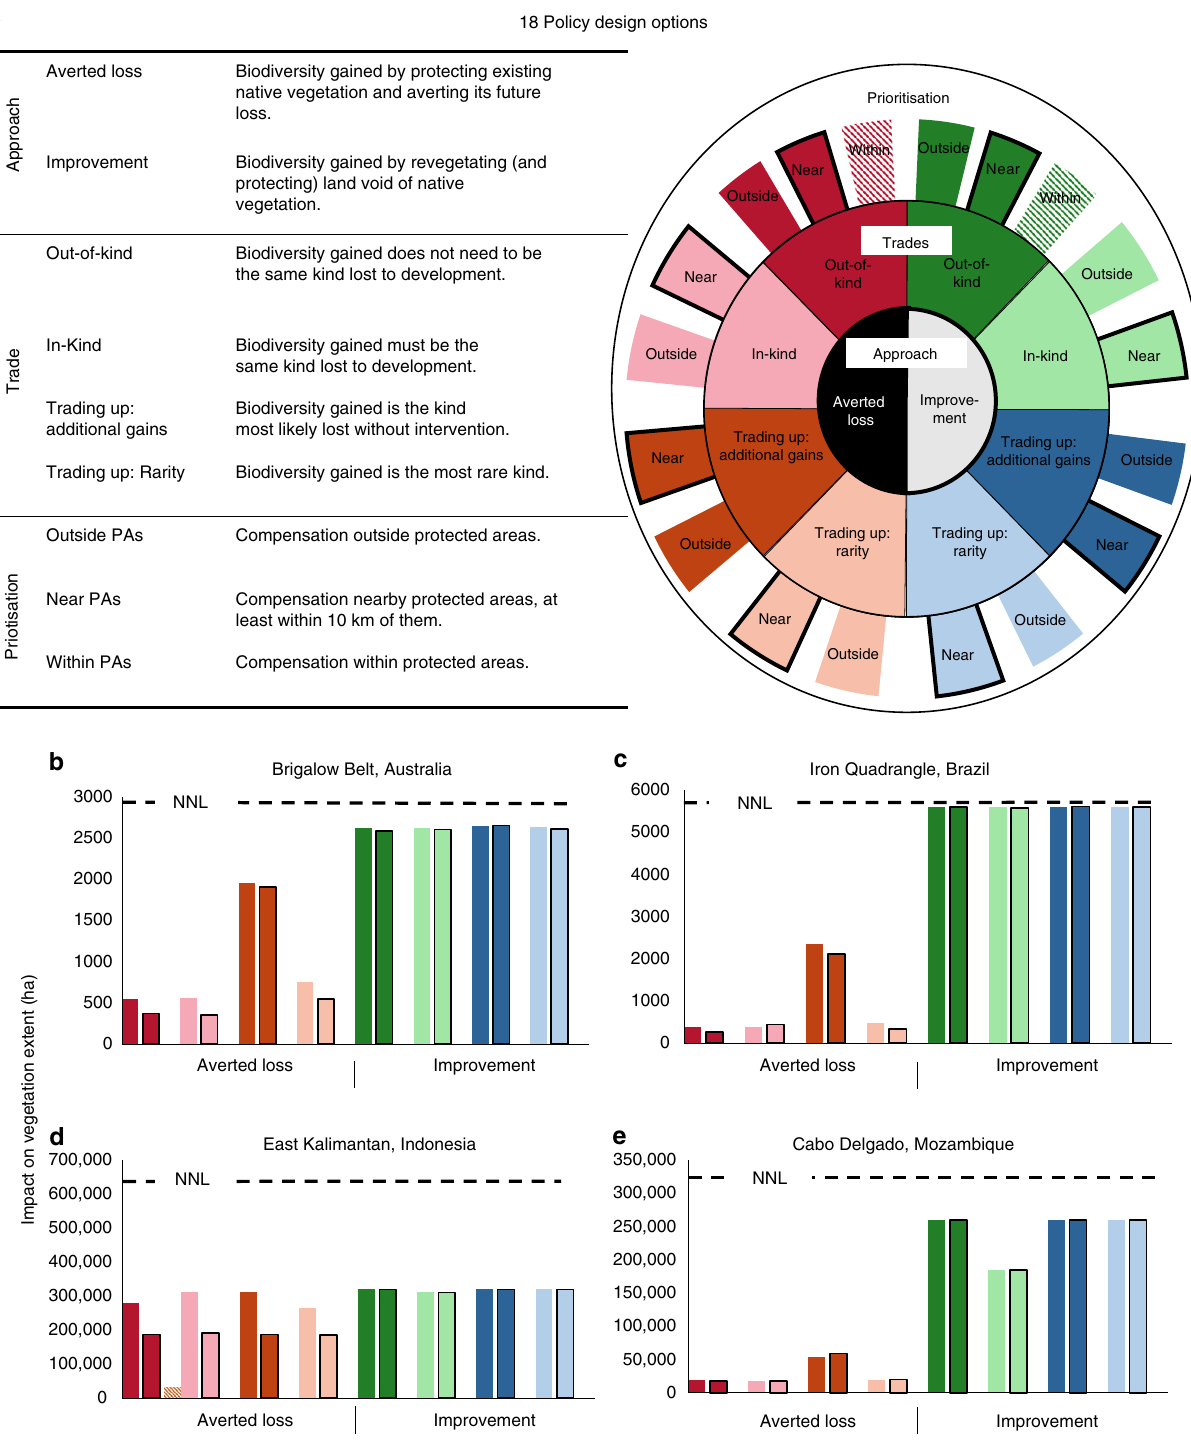
Fig. 2 Our 18 investgated compensation policy options and their impacts on biodiversity. a Policy design options representing two area-based approaches to achieving biodiversity gains, four options in trading biodiversity between development and compensation sites, and three methods of prioritising compensation activities to the landscape. Note: we only prioritised compensation Within PAs for Out-of-Kind trades, given that protected areas contained few opportunities for compensation (i.e. they did not contain much cleared land to restore, or experience large counterfactual losses to avert) and even more restrictive ‘ In-Kind ’ trades were rarely possible. Graphs b – e show negative impacts of regulated development (dashed black line, representing losses) and positive impacts of compensation policy designs (coloured bars, representing gains) on biodiversity (indicated by extent of native vegetation) across our four case study regions. No Net Loss (NNL) of biodiversity would have occurred if coloured bars met or exceeded dashed black lines. Coloured bars in b – e match the colour scheme shown in a